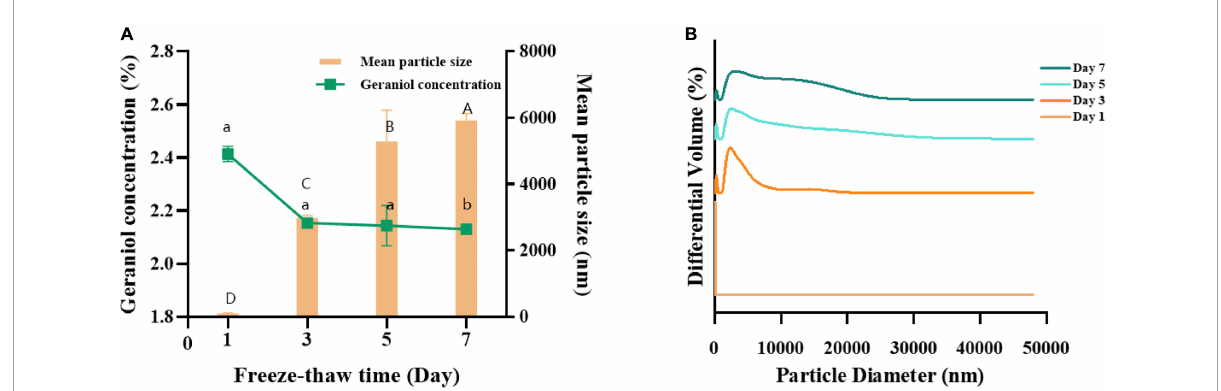
FIGURE8 Effect of freeze-thaw cycles on the mean particle size (A) , geraniol content (A) and particle size distribution (B) of G-NE. (Different capital (lowercase) letters indicate significant intra-group variability, p < 0.05 ; identical capital (lowercase) letters indicate significant inter-group variability, p > 0.05 ).